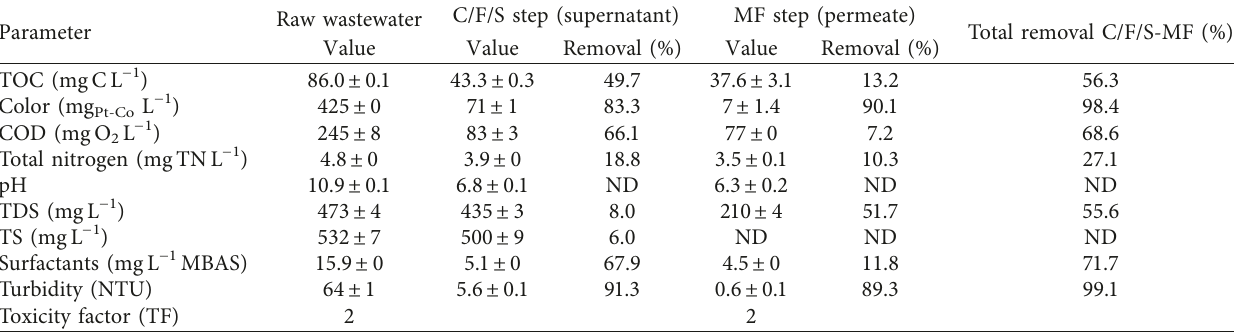
Table 9: Physicochemical parameters analyzed for the raw wastewater (batch 3), treated by C/F/S and microfiltration (MF), and removal efficiencies